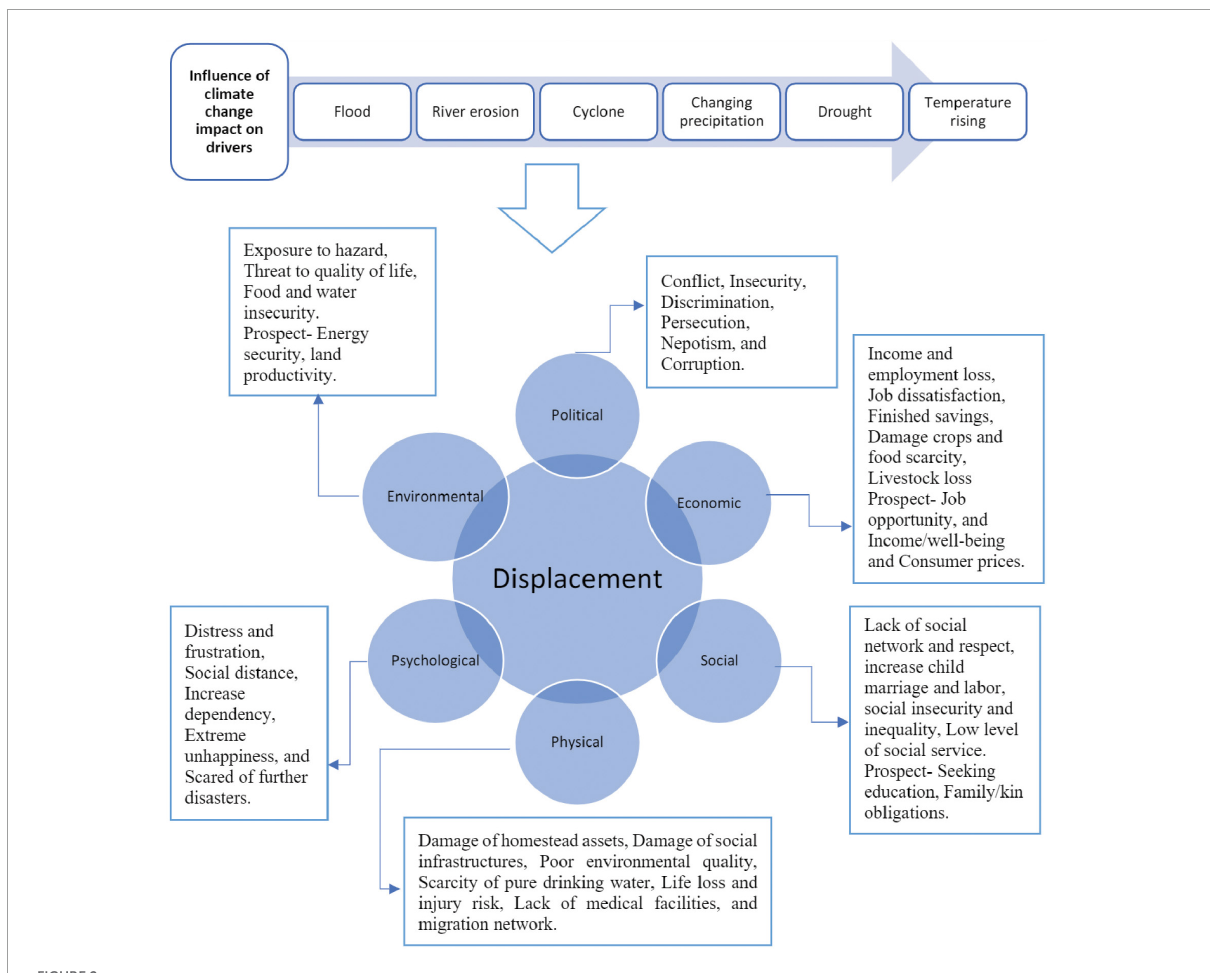
FIGURE2 Drivers and factors of displacement from riverine island areas in